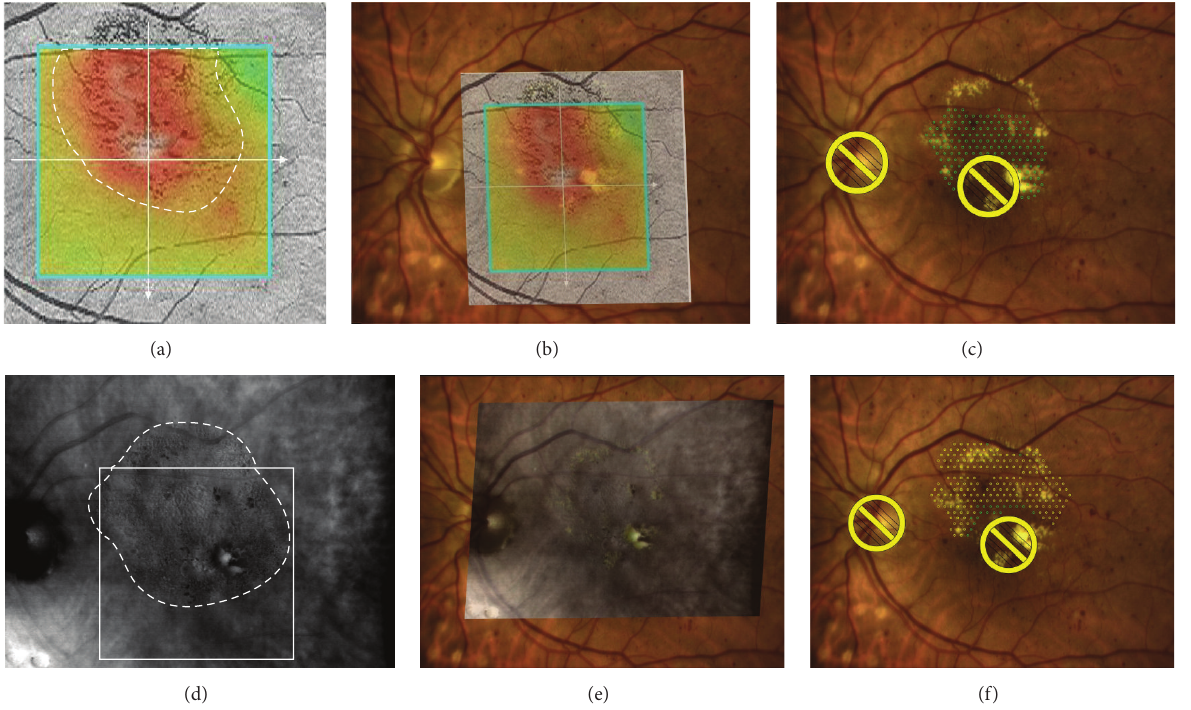
Figure 3: OCT- versus RM-SLO-guided treatment plan for macular laser photocoagulation. (a) OCT retinal thickness map fails to cover the entire zone of retinal edema (area, 9.33 mm 2 ). (b) OCT map superimposed onto the baseline image. (c) The number of laser spots placed in OCT-guided treatment planning is 149. (d) The entire zone of retinal edema is identified on RM-SLO image (entire edema area, 14.51mm 2 ; whitedashedlinerepresentstheedemazoneboundary;whitesquarerepresentsa5 mm × 5 mmzoneinvolvedintoOCTretinalthicknessmap; the area of edema identified by RM-SLO within the 5 mm × 5mm zone is 10.18mm 2 ). (e) RM-SLO image superimposed onto the baseline image. (f) The number of laser spots placed in RM-SLO-guided treatment planning is 219 (i.e., more than that in OCT-guided treatment